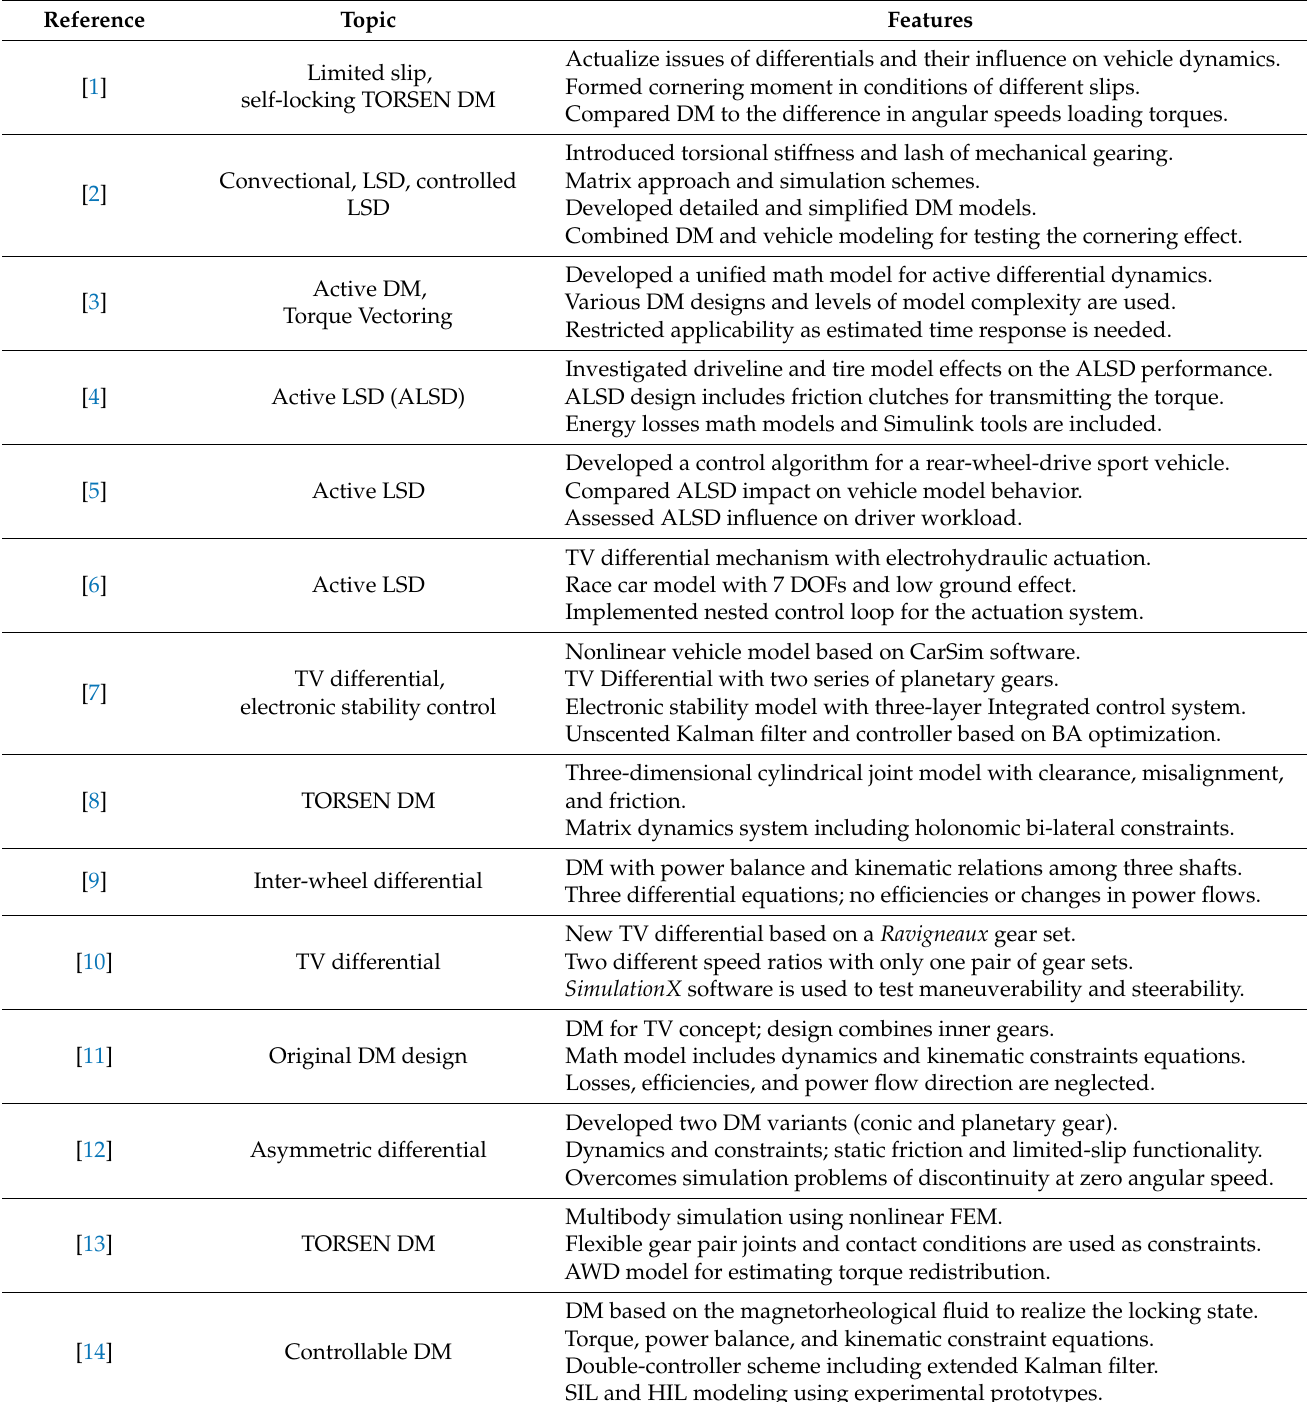
Table 1. Characteristics of selected studies on vehicle differential